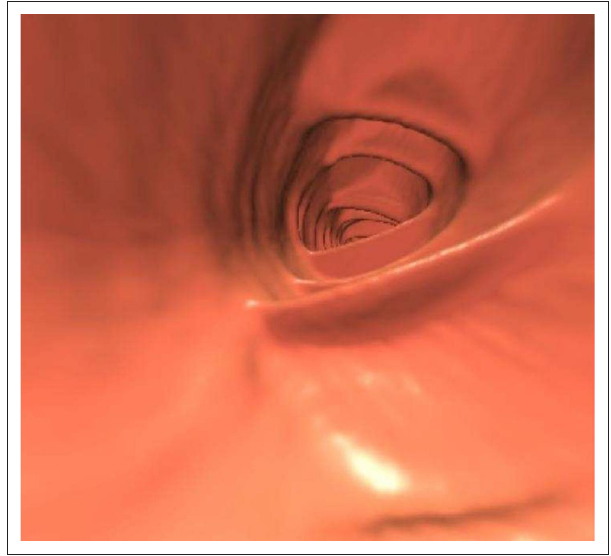
FIGURE 11: Left colon has circular folds (anal verge to splenic flexure).